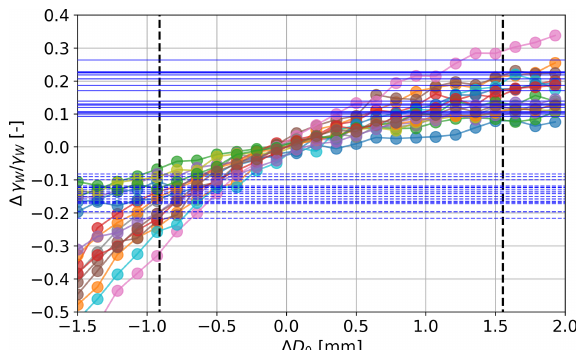
Figure 15. Colored lines with scattered points: relative change in W-band skewness γ W ( (cid:49)γ W /γ W ) caused by adding a diameter offset (cid:49)D 0 on microphysical descriptors of selected (time, range) gates, if assuming an exponential PSD. Horizontal lines: for each of these (time, range) gates, maximum relative change in skewness caused by a modification of the PSD shape (assumed a gamma dis- tribution, µ in the range [ − 2, + 5]); the maximum increase (respec- tively decrease) in skewness, solid line (respectively dashed line), is consistently obtained for µ = 5 (respectively µ = − 2). For each selected (time, range) gate, the intersection of the horizontal and colored lines gives a (cid:49)D 0 value which causes the same relative change in skewness as a change in PSD shape (worst case). Dashed vertical lines show the mean of these (cid:49)D 0